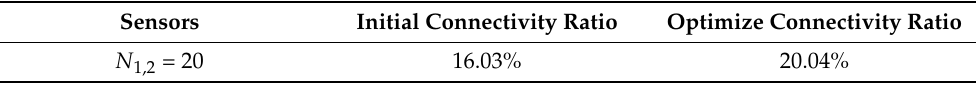
Table 16. Comparison of HWSN connectivity optimization experimental